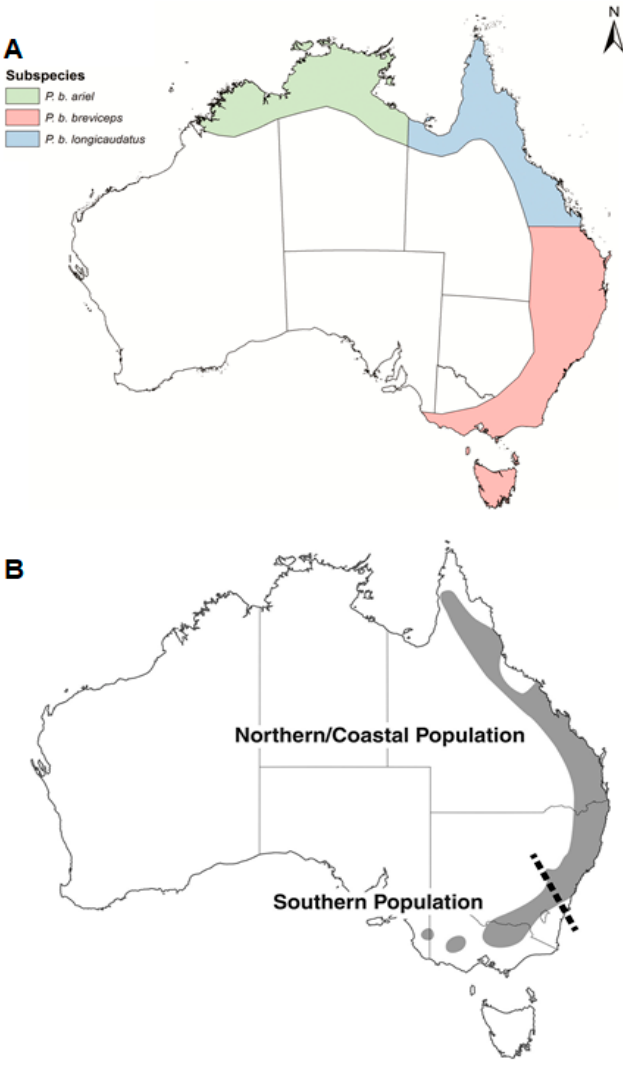
Figure 1. ( A ) P. breviceps subspecies distribution within Australia. Figure taken from Cremona et al. [15]; ( B ) P. norfolcensis distribution within Australia. Areas either side of the dashed line represent two genetically distinct populations. Figure taken from Crane et al. [16].